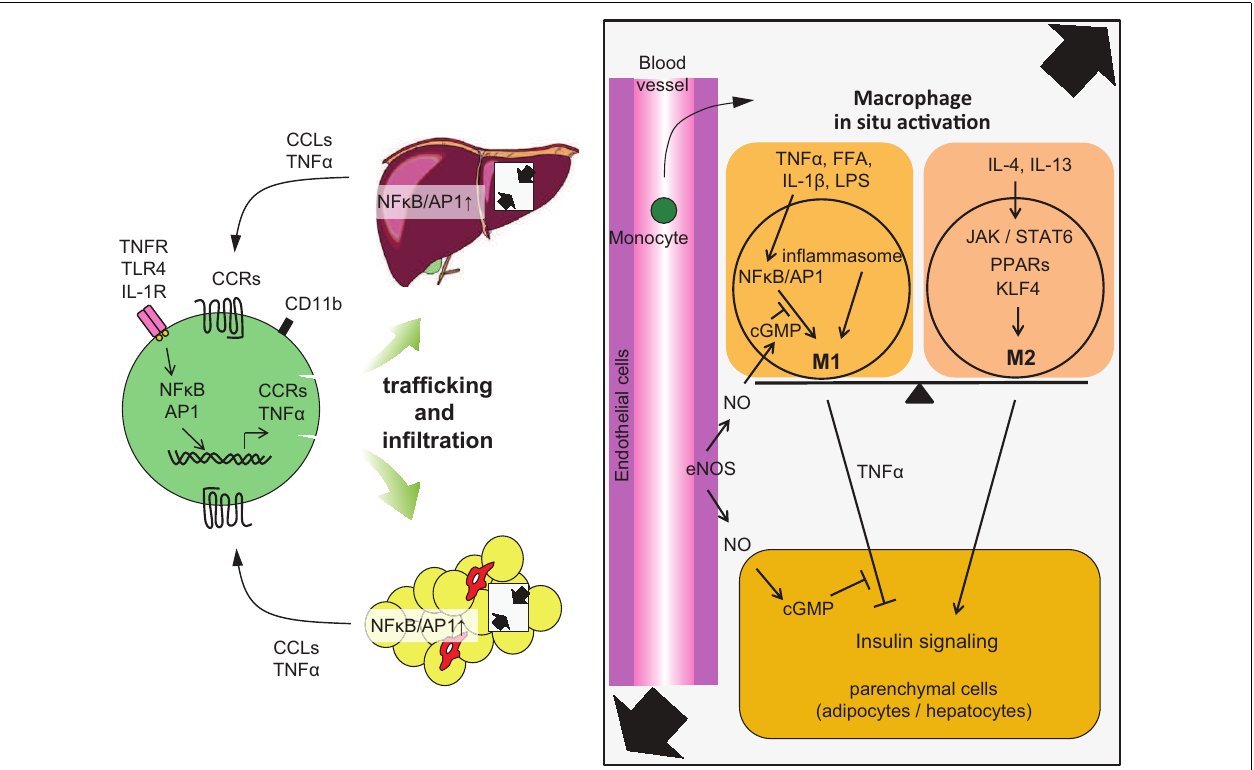
FIGURE 2 |Accumulation of monocytes/macrophages in adipose tissue and liver, and activation in the tissues .Trafficking: During obesity, adipocytes exhibit hypertrophy, while liver incorporates substantial FFAs, both of which cause tissue inflammation, activation of NF- κ B, and AP1 signaling, leading to increased secretion of inflammatory chemokines and cytokines, including CCLs andTNF α . Elevated secretion of CCLs (e.g., MCP-1) elicits the accumulation of CCR-positive monocytes to the site of inflammation, particularly CCR2 + for adipose and liver, but CCR5 + for adipose tissue. In situ activation: In a lean state, resident tissue macrophages display the M2 phenotype, which is achieved and sustained through the JAK/STAT6